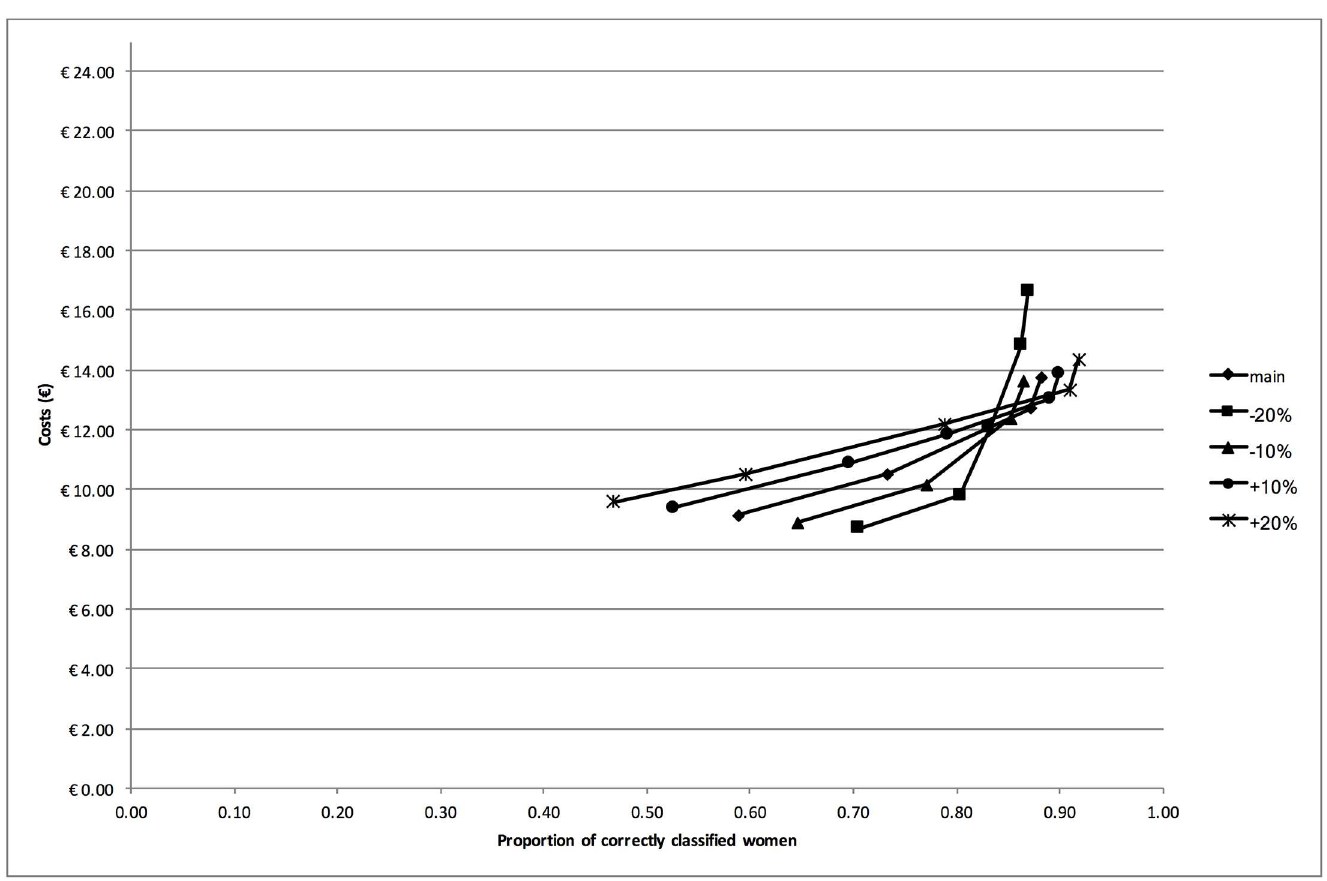
Fig 5. Cost-effectivenessplane for the univariate sensitivity analysis. The cost-effectiveness plane shows the efficiency frontiers for the univariate sensitivity analysesin which the prevalence of urinary tract infection was varied by plus and minus 10% and 20%.